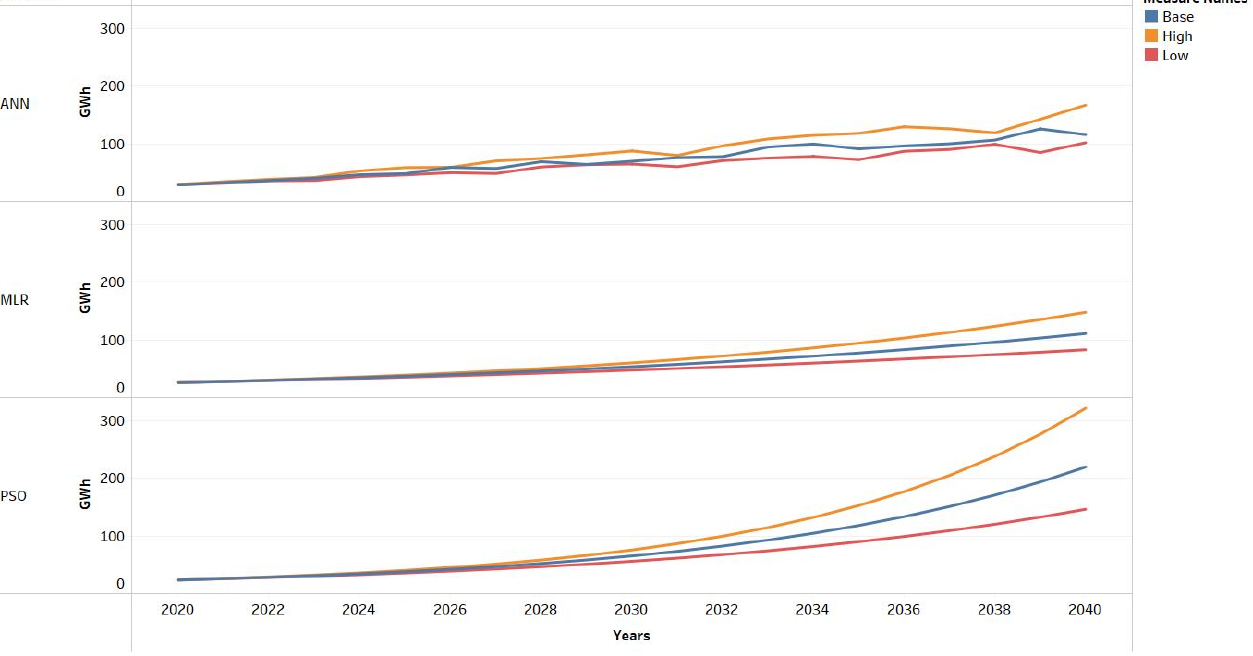
Figure 13. Electricity energy demand forecasting results by using ANN, MLR, and PSO.